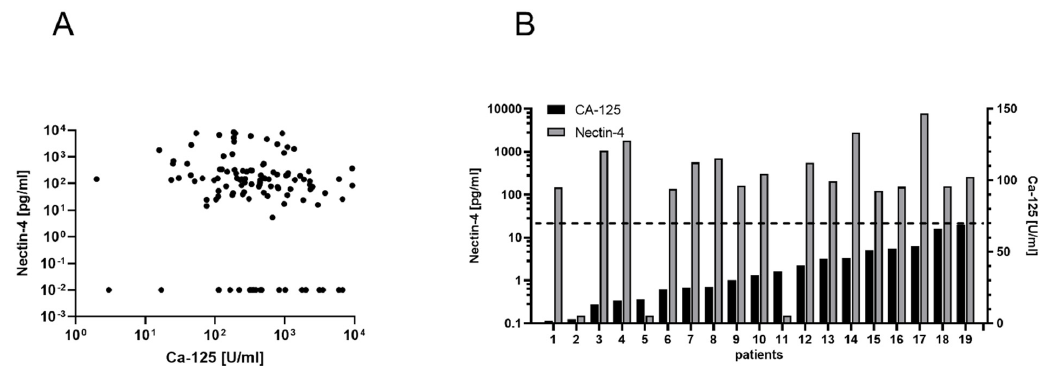
Figure 4. ( A ) Scatterplot of Nectin-4 and Ca-125 in 122 OvCa patients. ( B ) Most patients with low Ca-125 levels have high Nectin-4 levels. Gray columns show Nectin-4 levels and black columns show Ca-125 levels of individual patients. The dashed horizontal line indicates the cutoff value for Ca-125 of 70 U/mL.